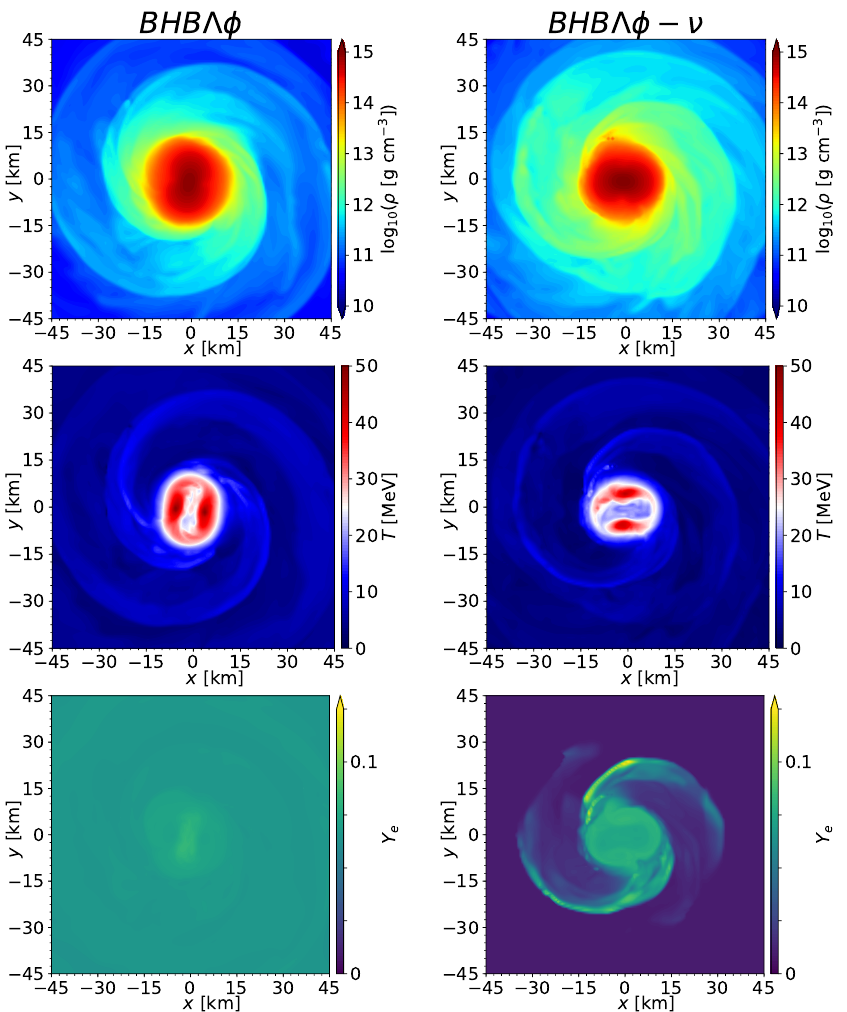
Figure 10. Snapshots of hydrodynamical quantities of the simulations using BHB Λ φ and BHB Λ φ - ν 10 ms after the merger on the x - y plane. From top to bottom, we have the rest-mass density, temperature, and electron fraction.